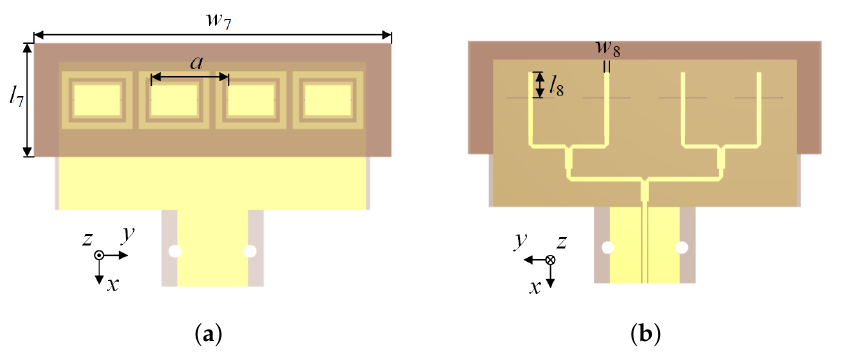
Figure 4. Geometry of the proposed 4 × 1 linear array antenna: ( a ) top view, ( b ) bottom